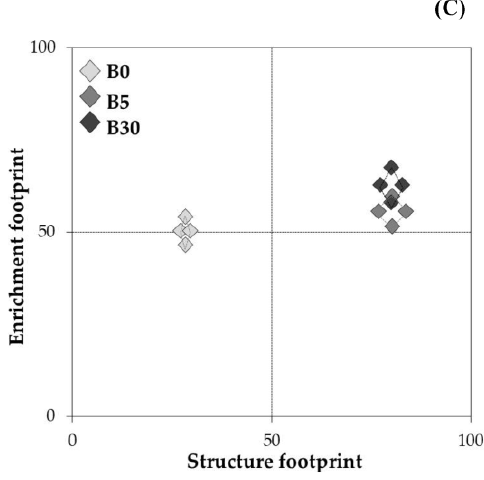
Figure 3. Abundance of total nematodes and nematode-related ecological indicators in the lower layer under biochar amended 0.3% (B5), 1.8% (B30) and not-amended upper layer (B0): total nematodes and community composition ( A ), nematode indices ( B ), and metabolic footprint ( C ) after 16 weeks of mung bean residue incorporation. Bars present the average and standard error (n = 3). Different letters present the significant differences ( p < 0.05) among treatments by Tukey’s HSD test. The metabolic footprint of nematodes presents the C sources that use for assimilation and respiration through nematodes community [38]. Bigger area size indicates the more energy transform through nematode.